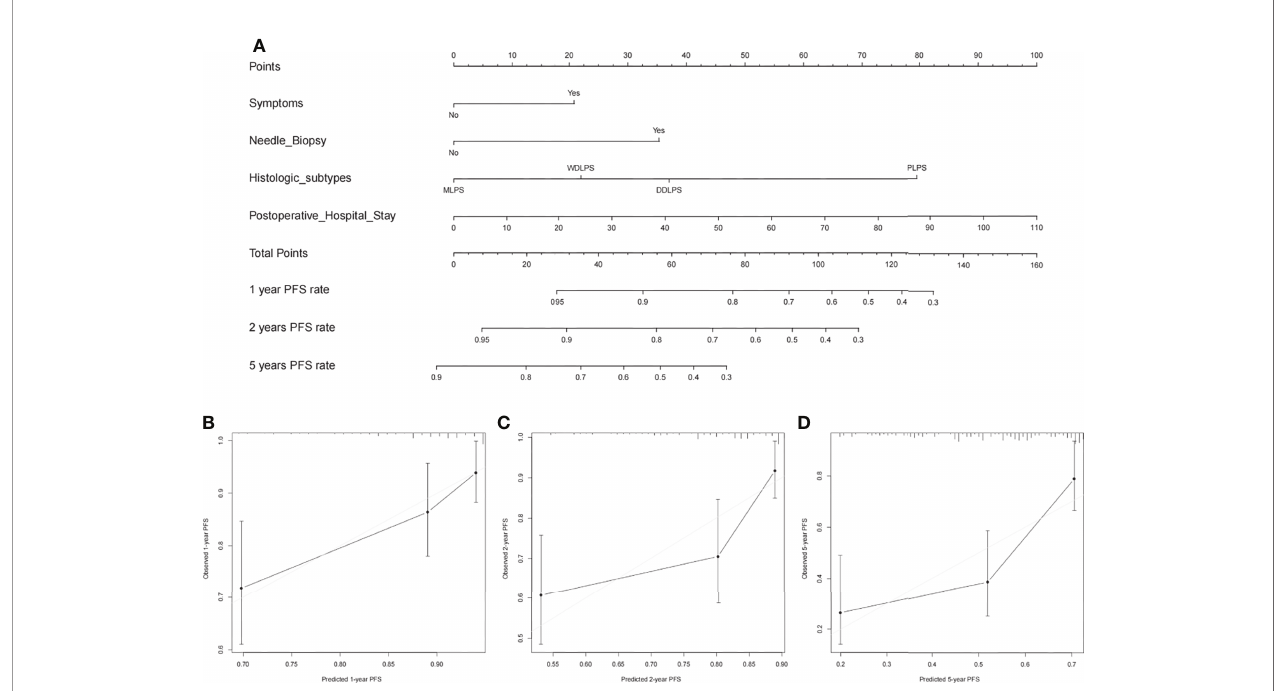
FIGURE 3 | (A) Nomogram for 1-, 2-, and 5-year progression-free survival in patients with primary retroperitoneal liposarcoma and calibration plots for internal validation of (B) 1-, (C) 2-, and (D) 5-year progression-free survival